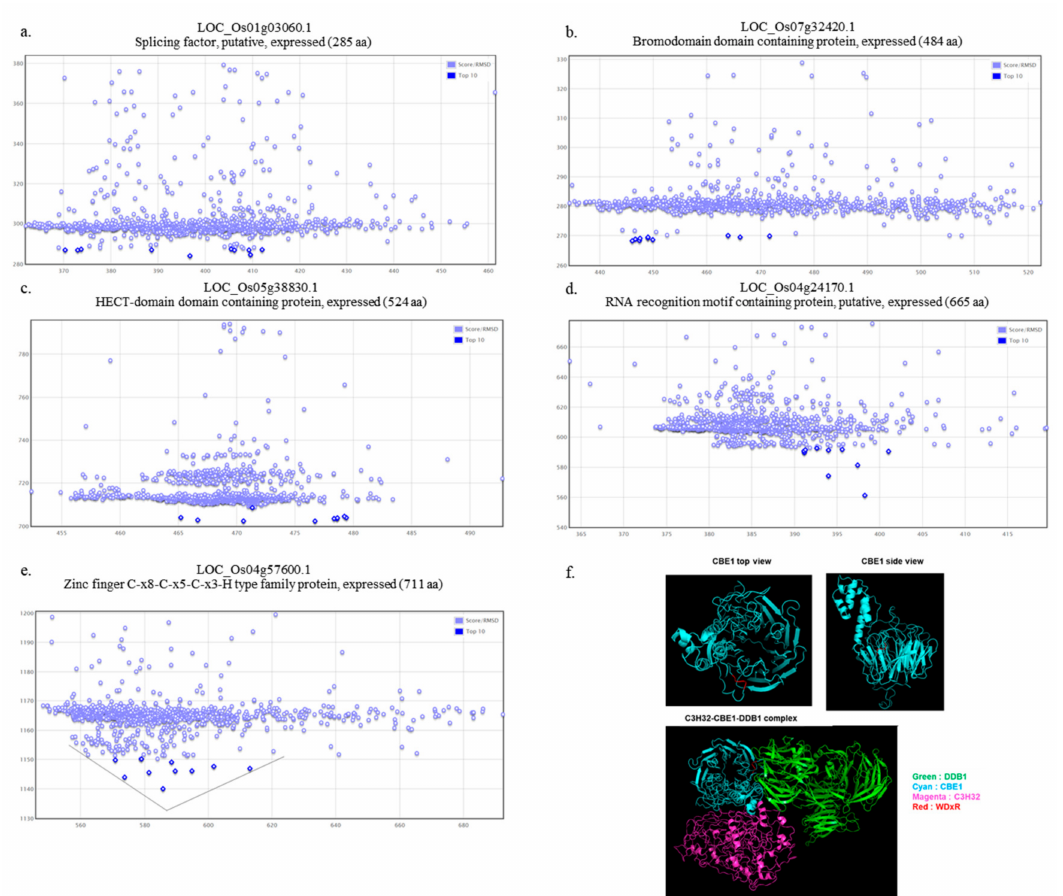
Figure 4. In silico identification of the OsCBE1 binding partners. ( a – e ) Energy plot of interaction energy between OsCBE1 and five putative substrates, LOC_Os01g03060.1 ( a ), LOC_Os07g32420.1 ( b ), LOC_Os05g38830.1 ( c ), LOC_Os04g24170.1 ( d ), and LOC_Os04g57600.1 ( e ), and Root-mean-square deviation of atomic positions (RMSD). Energy diagram of LOC_Os01g03060.1, LOC_Os07g32420.1, and LOC_Os05g38830.1 have horizontal distribution. Energy diagram of LOC_Os04g24170.1 has three downward plots, but most of the distribution is horizontal. Only the energy diagram of LOC_Os04g57600.1 shows funnel-like distribution (marked with black lines). ( f ) Predicted structure of OsCBE1 and OsDDB1-OsCBE1-OsC3H32